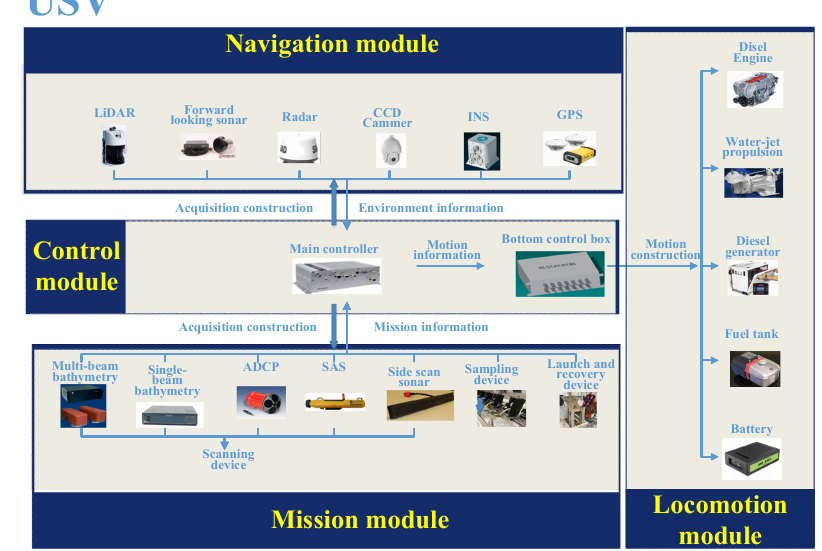
Figure 2. Unmanned surface vehicle (USV) architecture overview.